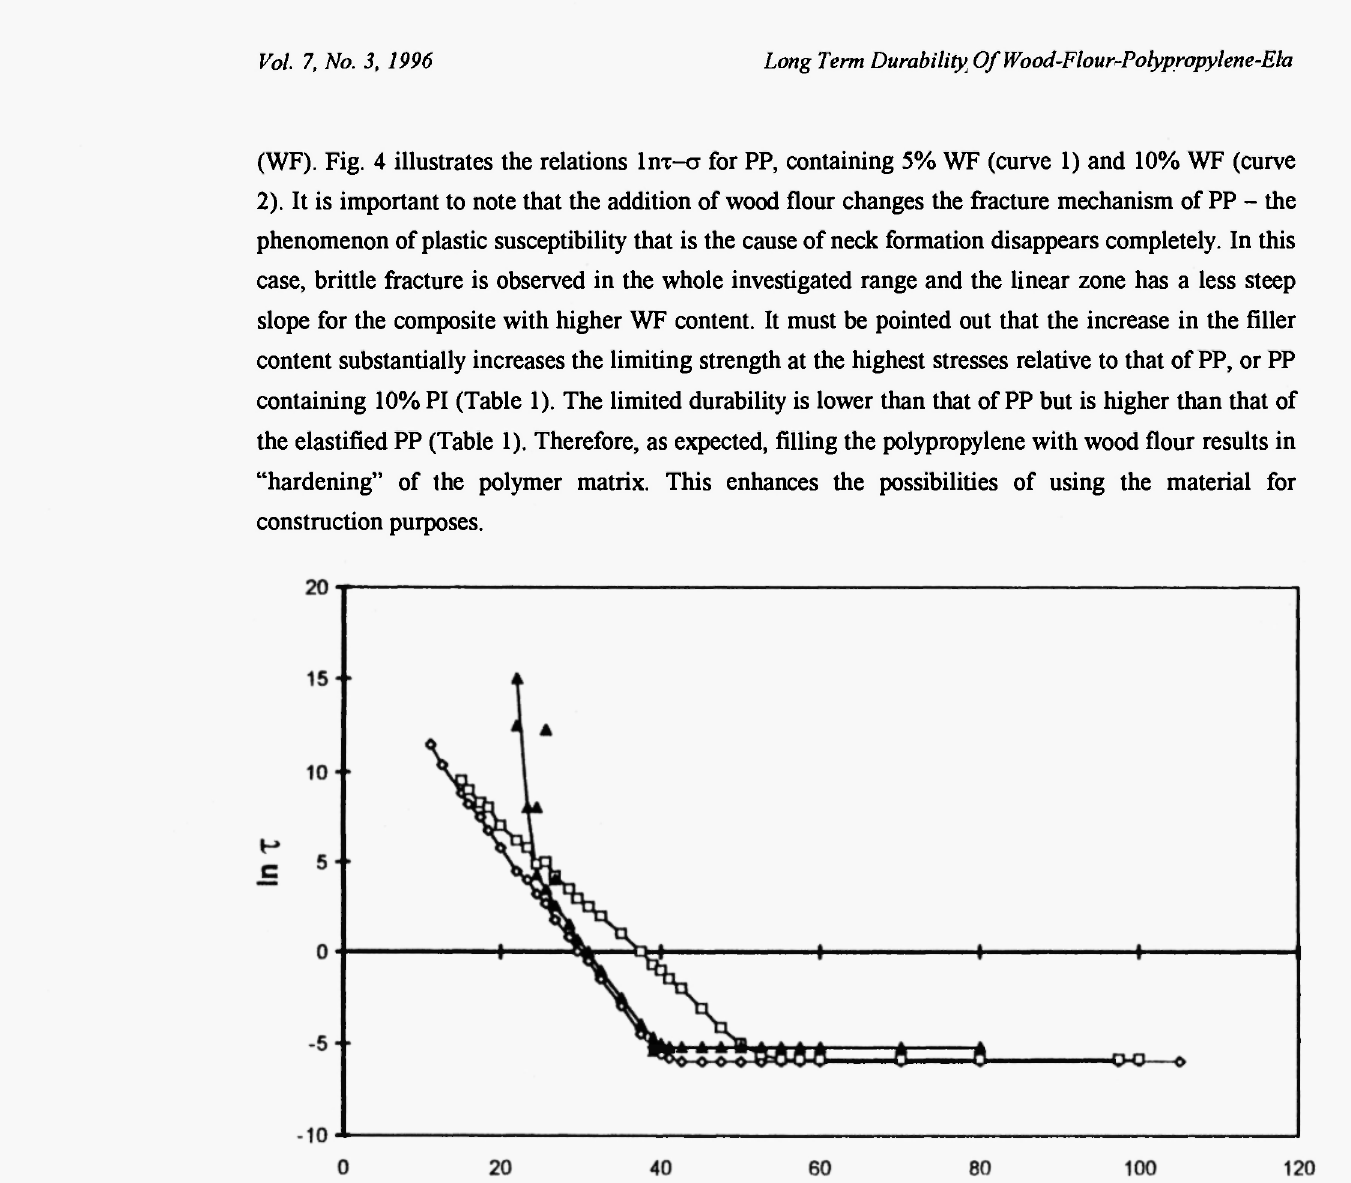
Fig. 4: Semi-logarithmic form of the time dependence of the strength for PP containing 5% WF (O), PP containing 10% WF ( •) and PP